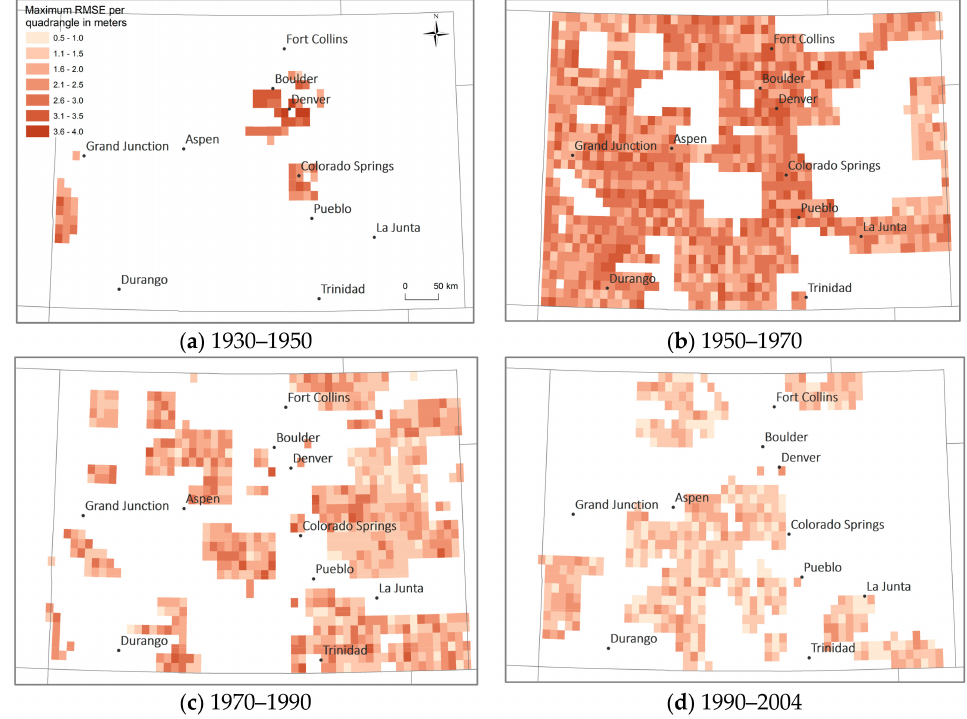
Figure 9. Spatio-temporal patterns of georeference accuracy of USGS topographic maps (1:24,000) in the state of Colorado (USA), for maps produced between ( a ) 1930–1950, ( b ) 1950–1970, ( c ) 1970–1990, and ( d )